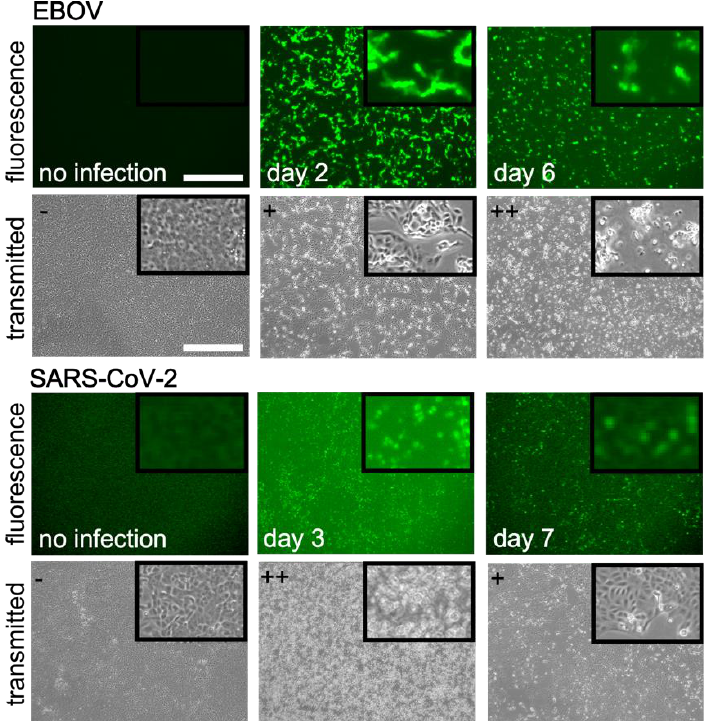
Figure 1. Timing and detection of virus spread. Fluorescence and transmitted light images of EBOV and SARS-CoV-2 infected Vero E6 cells on indicated days after infection. Images were taken on the indicated days when green fluorescence or CPE was visible and compared to cells without virus. GFP (EBOV) or mNeonGreen (SARS-CoV-2) signals precede CPE for both viruses. For EBOV, GFP is strongly expressed on day 2. For SARS-CoV-2, the signal was fainter but clearly visible on day 3 together with CPE. For EBOV, CPE appeared later than SARS-CoV-2 being evident on day 7. At top left of brightfield images grading for CPE is given with - = none, + = low and ++ = high CPE. Scale bar is 500 mm with all images taken at the same magnification.